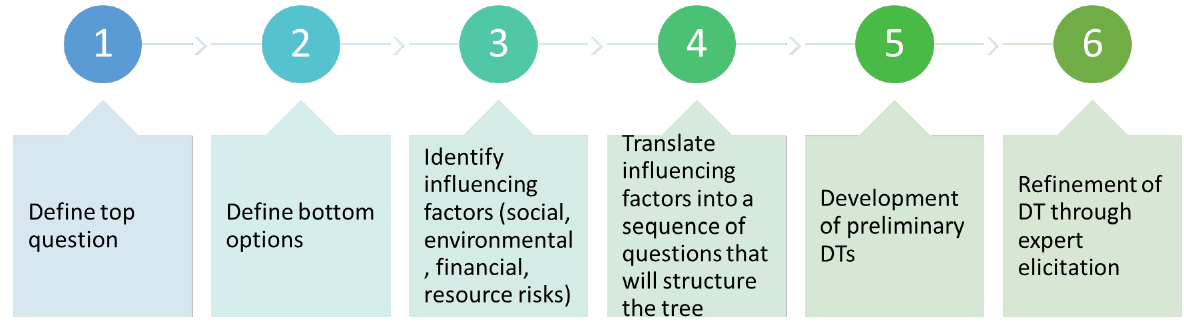
Figure 3. Decision tree development methodology (Source: [59]) .